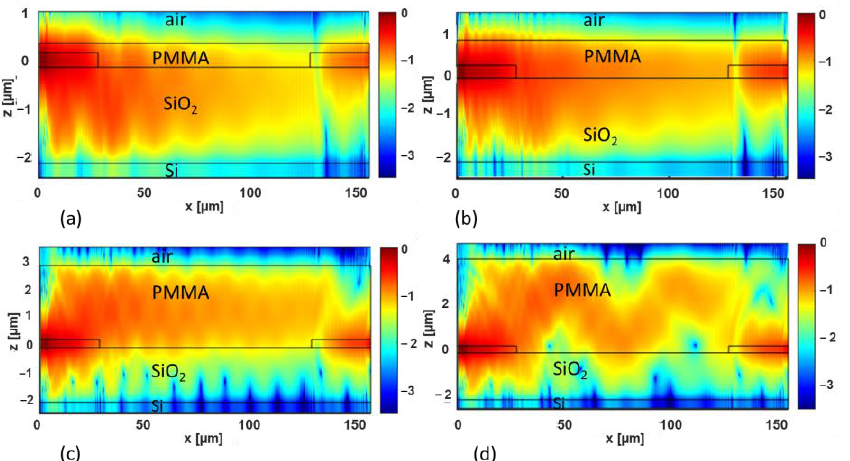
Figure 10. Normalized electric field (in logarithmic scale) calculated in the xz-vertical plane for y = 0 µ m (i.e., in the middle of the antennas) for the TE polarization. The link distance is d link = 100 µ m and different values of the thickness d are considered, namely: ( a ) d = 0.5 µ m, ( b ) d = 0.9 µ m, ( c ) d = 3 µ m, and ( d ) d = 4 µ m. The antennas and the multilayer interfaces are denoted by the black lines. The wavelength is λ = 1.55 µ